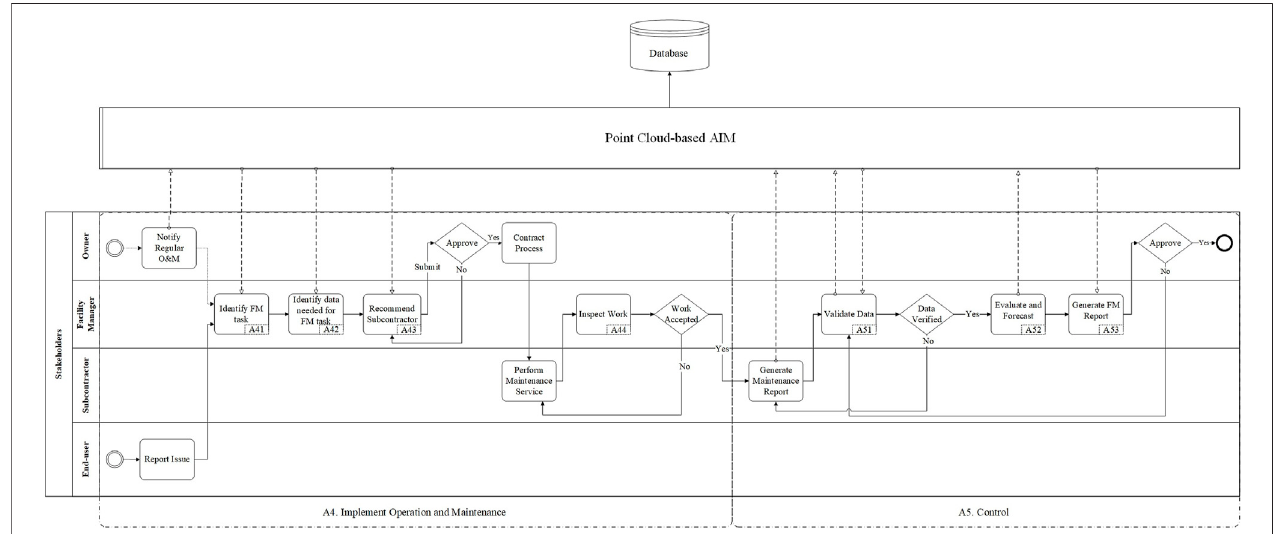
FIGURE 9 | Stakeholder ’ s responsibility and the data fl ow in a FM session.